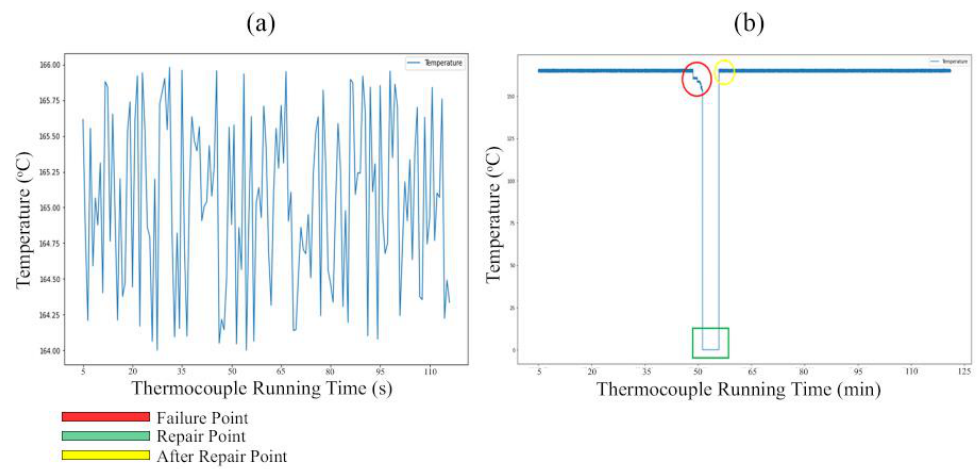
Figure 9. Graphs of sample temperature data in ( a ) normal condition, ( b ) failure condition.